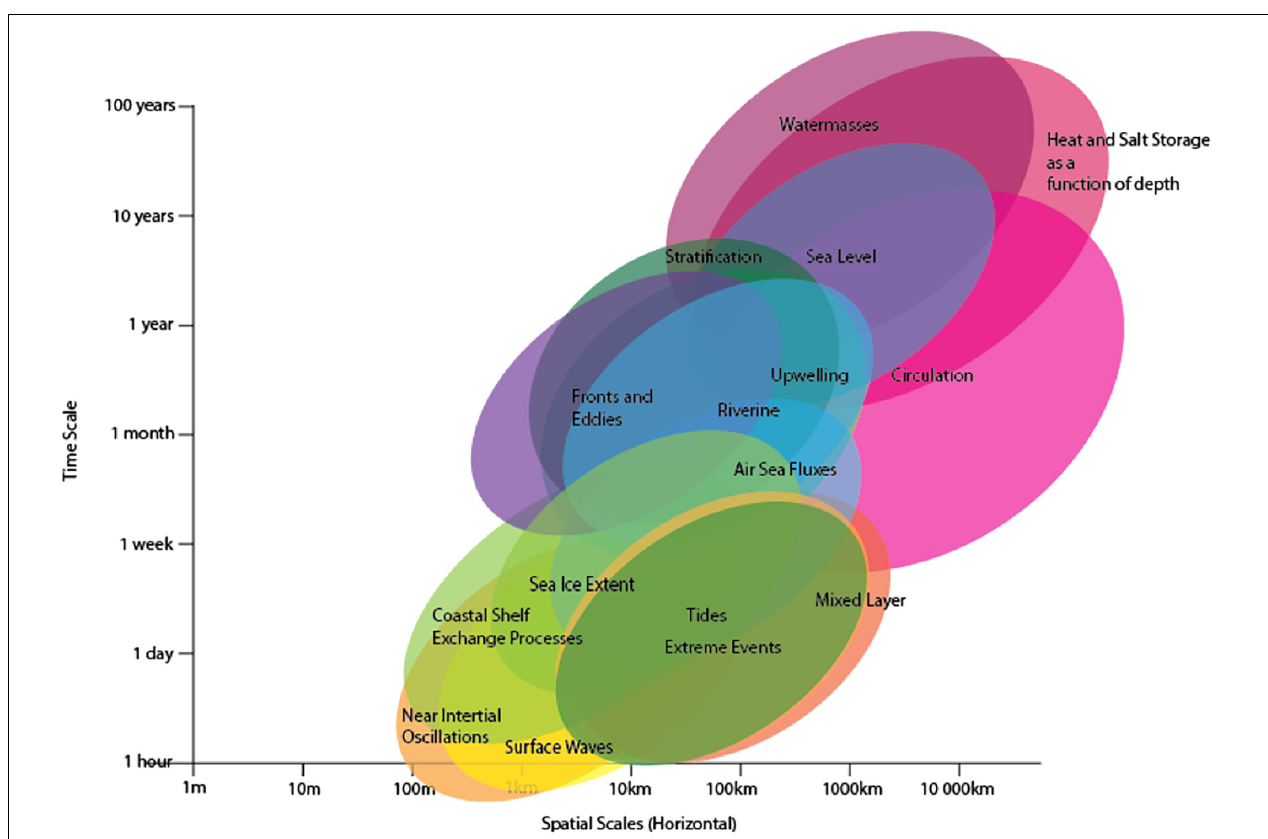
FIGURE 1 | Stommel diagram of key ocean physics phenomena that need to be derived or observed form ocean